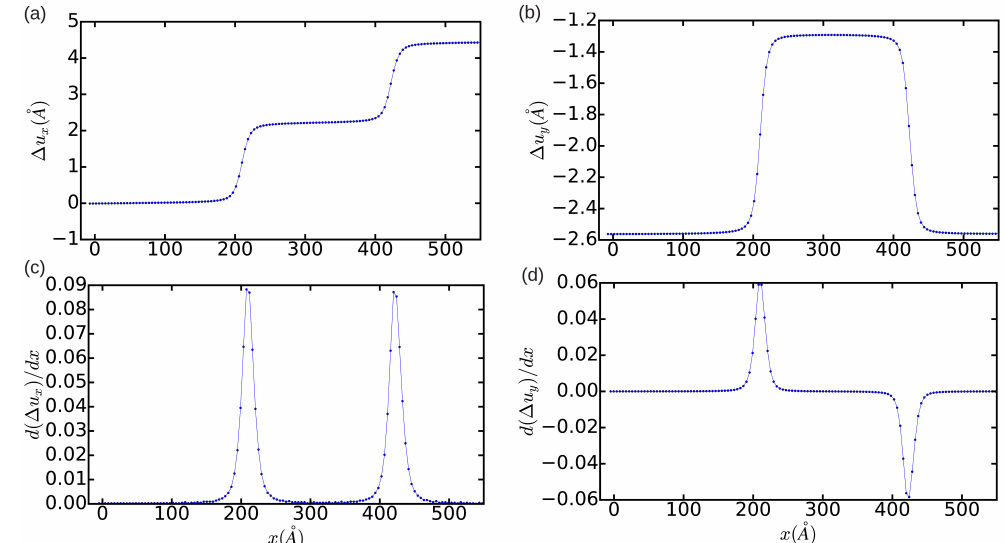
Figure 2. Relative displacement ( a , b ) and differential displacement ( c , d ) of the atoms above and below the glide plane of the edge dislocation in the x - and y -directions. The simulation cell contains n = 344,544 atoms and is fully